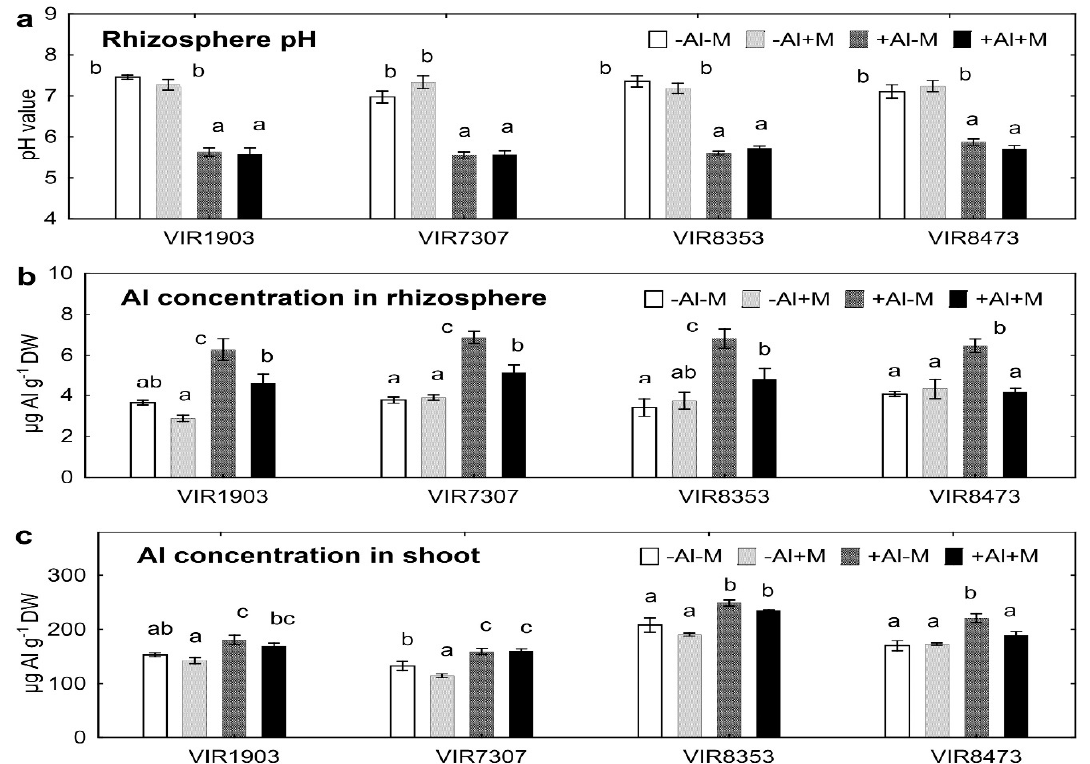
Figure 3. Rhizosphere pH ( a ) and concentration of Al in the rhizosphere ( b ) and shoots ( c ) of pea genotypes VIR1903, VIR7307, VIR8353 and VIR8473 inoculated with microbial consortium. See details